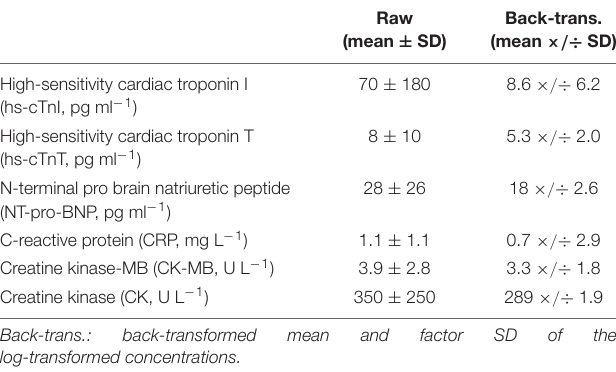
TABLE 1 | The pre-exercise concentrations of